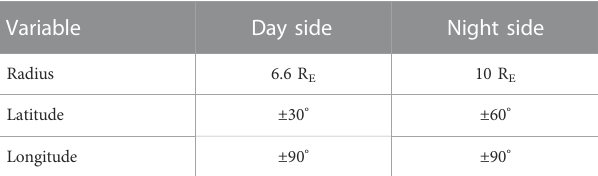
TABLE 1 Limits of the surface of measurement through which fl uence is calculated.